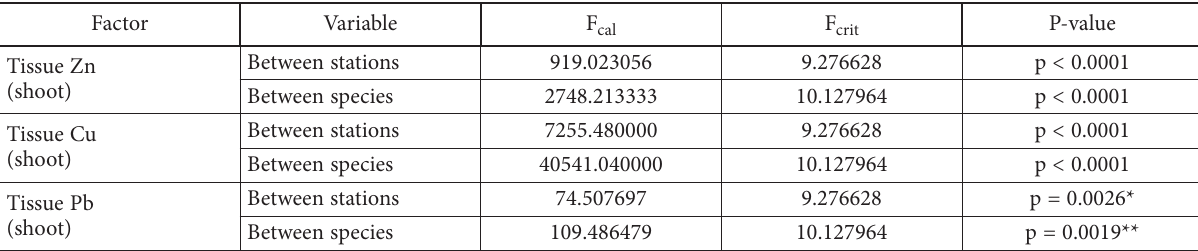
Table 5. ANOVA of heavy metal concentrations in the shoot samples between stations and between species Factor Variable F cal F crit P-value Between stations 919.023056 9.276628 p < 0.0001 Tissue Zn (shoot) Between species 2748.213333